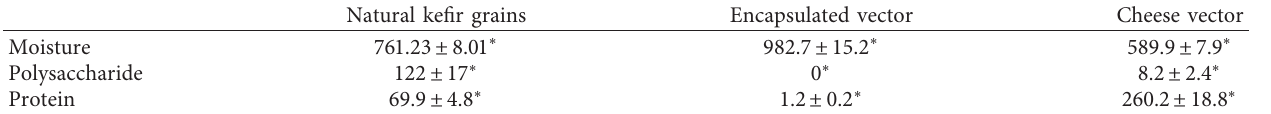
Figure 1: Physical appearance of natural kefir grains and different vectors: (a) Natural kefir grains; (b) encapsulated vector; (c) cheese vector. Table 1: Chemical properties of natural kefir grains and different vectors